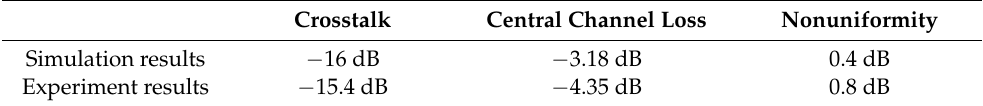
Table 2. Comparison of the simulation and experiment results.